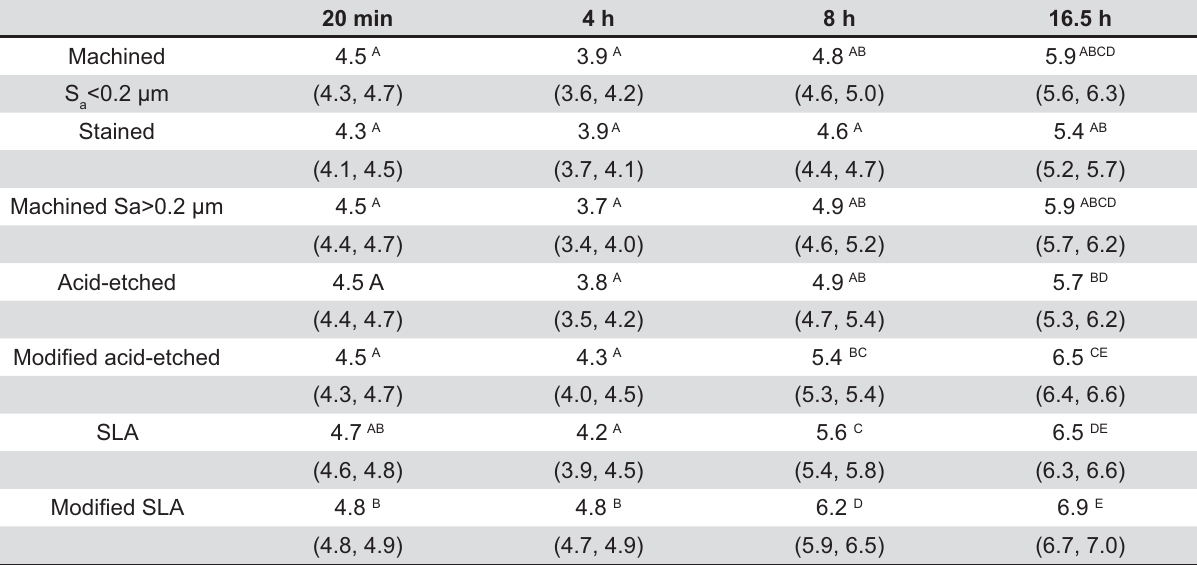
(cid:18)(cid:6)’’(cid:8)(cid:20)(cid:8)(cid:7)(cid:25)(cid:10)(cid:21)(cid:29)(cid:28)(cid:8)(cid:20)(cid:21)(cid:4)(cid:20)(cid:6)(cid:28)(cid:25)(cid:10)#(cid:8)(cid:25)(cid:25)(cid:8)(cid:20)(cid:21)(cid:10)(cid:20)(cid:8)(cid:28)(cid:20)(cid:8)(cid:21)(cid:8)(cid:7)(cid:25)(cid:10)(cid:21)(cid:6)(cid:19)(cid:7)(cid:6)9(cid:4)(cid:3)(cid:7)(cid:25)(cid:10)(cid:9)(cid:6)’’(cid:8)(cid:20)(cid:8)(cid:7)(cid:4)(cid:8)(cid:21)(cid:10)=?|~(cid:127)?(cid:10)(cid:3)(cid:7)(cid:9)(cid:10)(cid:11)(cid:4)(cid:5)(cid:8)’’(cid:128)(cid:10) post hoc analysis, read vertically). SLA: